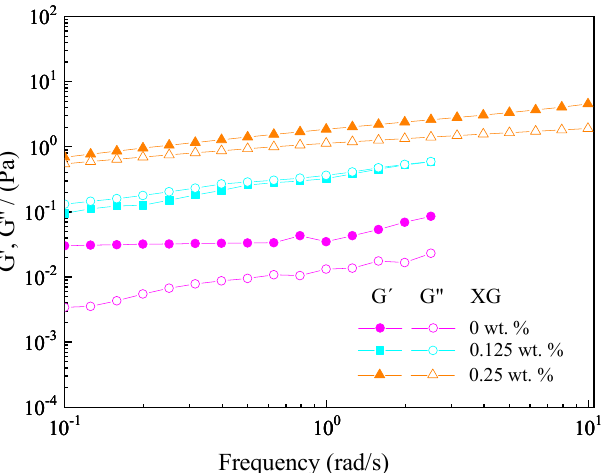
Figure 7. Viscoelastic moduli (G′ and G″) as a function of frequency of W 1 /O/W 2 multiple emulsions obtained at three different xanthan gum (XG) concentrations (0, 0.125 and 0.25 wt.%) obtained the same day emulsion preparation.